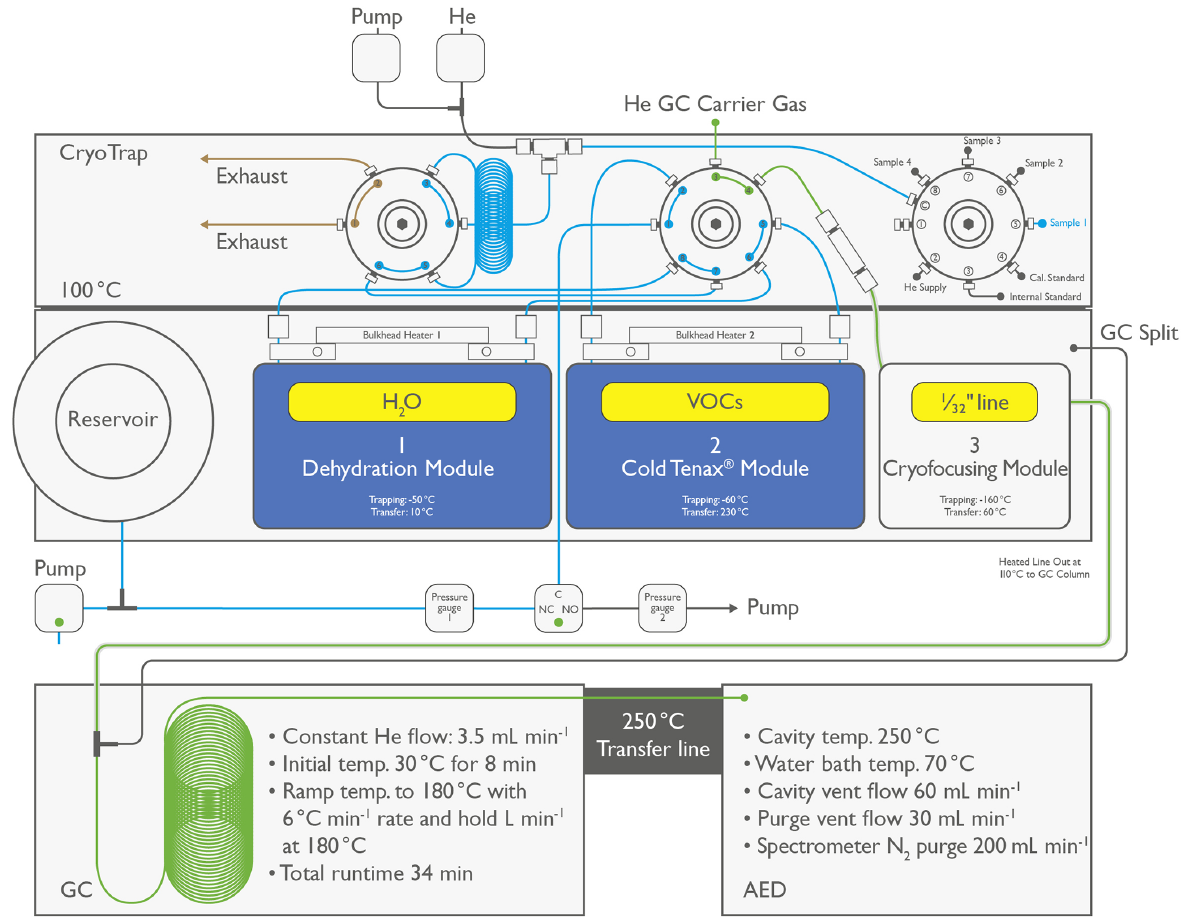
Figure 1. Schematic overview of the instrumental setup for the CryoTrap–GC–AED. Blue indicates the CryoTrap sample pre-concentration flow pathway through tarps 1 and 2, starting from the sample 1 inlet position. Green indicates the GC–AED He flow through the column leading to the He